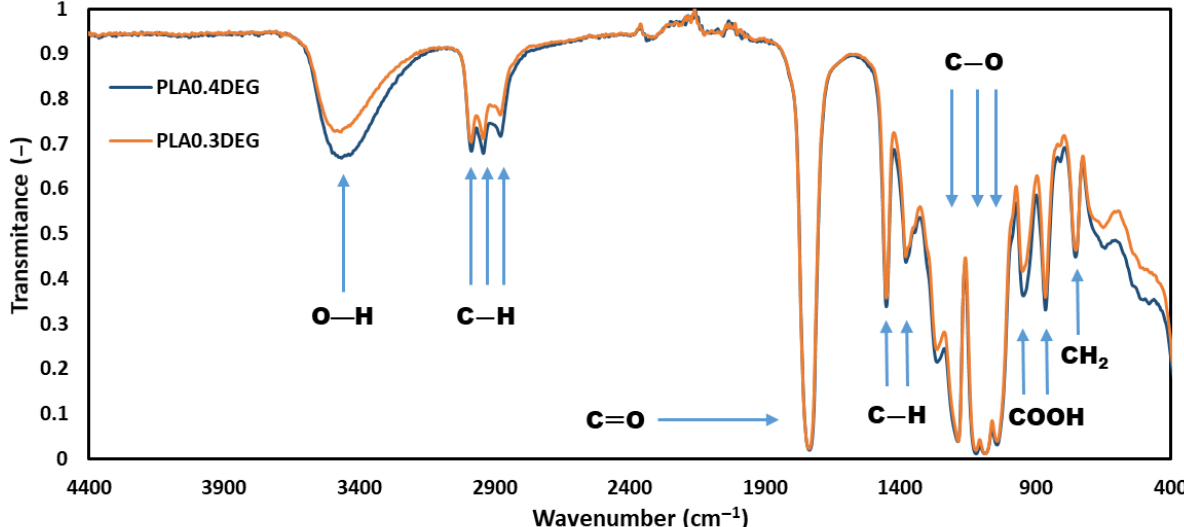
Figure 3. FTIR spectra of new eco-polyols.